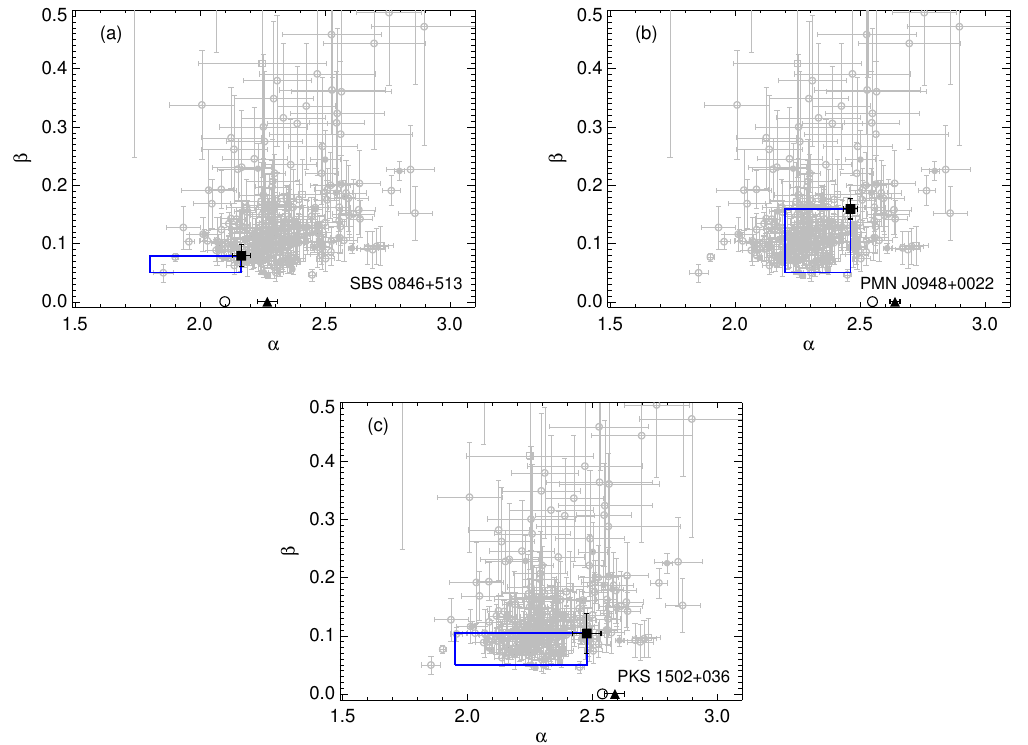
Figure 6. Scatter-plot of the two spectral parameters ( α and β ) for the different object categories (see Figure 1 for the description of the different symbols). The black filled squares represent the 4FGL values, while the black filled triangles represent the value of the photon index Γ for a power-law fit in 4FGL. The black open circles represent the value of the photon index Γ for the different sources in the high γ -ray state as reported in [9]. Blue rectangles represent the intervals, in α and β , defined by the red and green dashed curves in Figure 3. ( a ) SBS 0846 + 513. ( b ) PMN 0948 + 0022. ( c ) PKS 1502 +